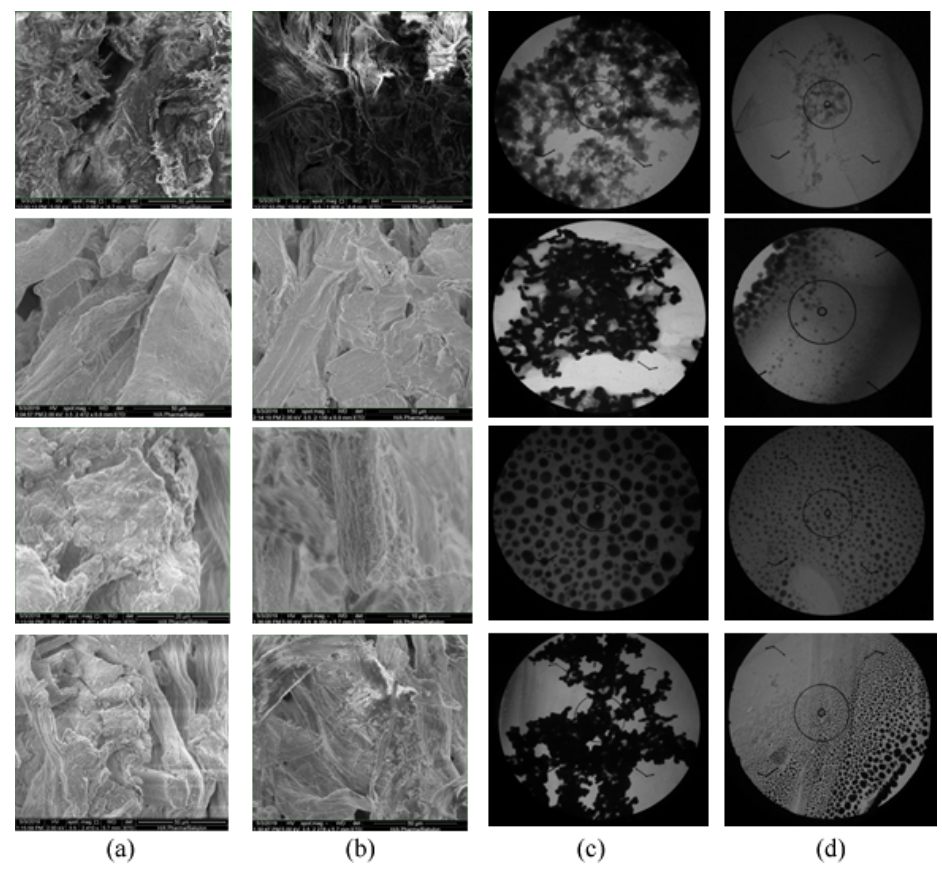
Figure 2. (a) Images obtained from SEM using 2 : 1 NaBH 4 / AgNO 3 ratio. (b) Images obtained from SEM using 10 : 1 NaBH 4 / AgNO 3 ratio. (c) TEM images using 2 : 1 NaBH 4 / AgNO 3 ratio. (d) TEM images using 10 : 1 NaBH 4 / AgNO 3 ratio. Table 3. AAS test showing the silver content of each